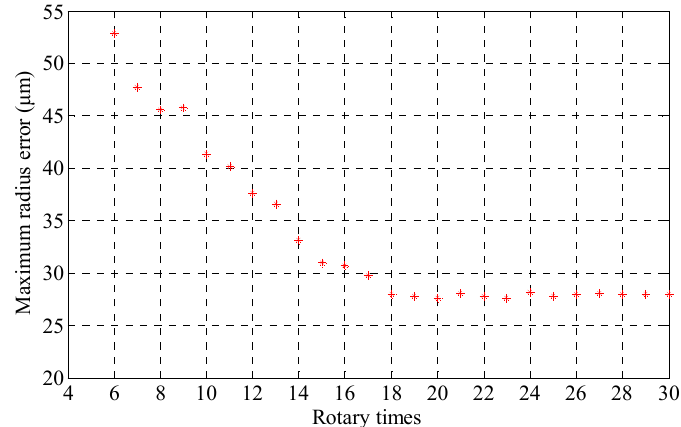
Figure 11. The measurement results for different rotation times of the measuring rod.